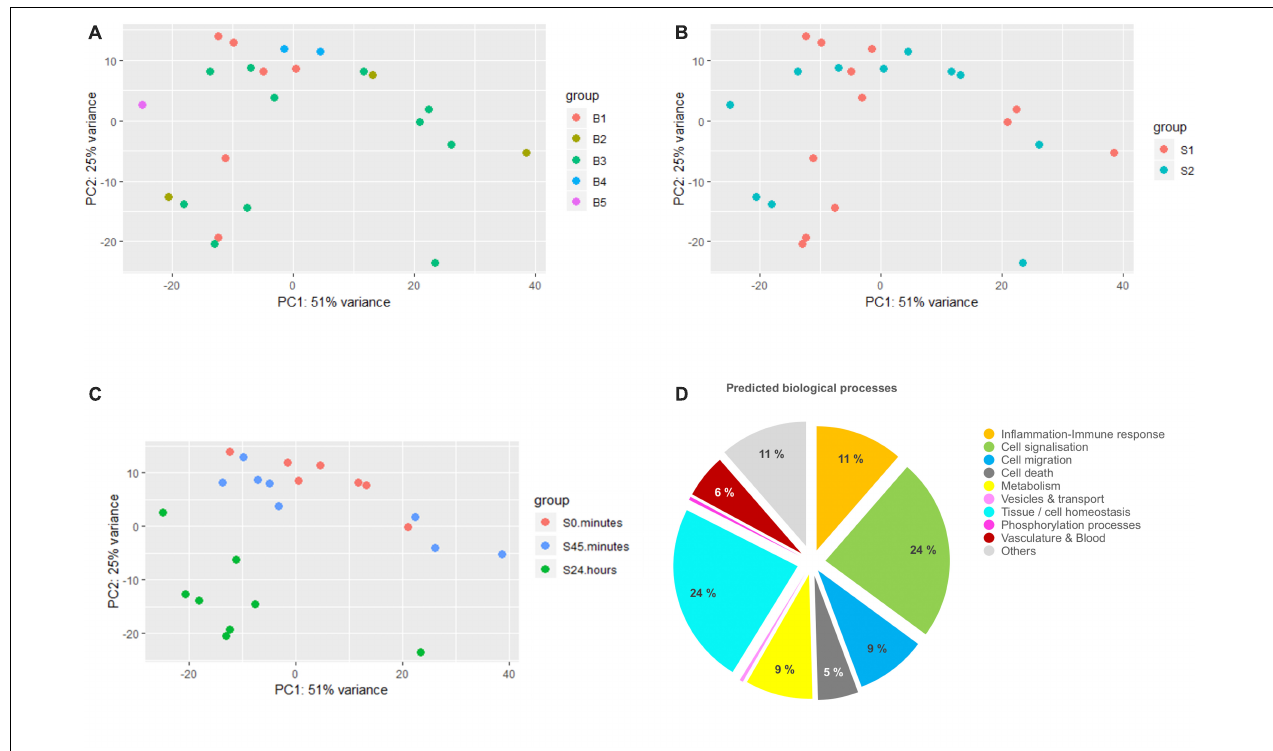
FIGURE 1 | Differential analysis and gene ontology analysis. (A–C) represent principal component analysis (PCA) plots of the data clustered by surgeon (S1 and S2), batch (B1–B5), and time (0 min, 45 min, and 24 h), respectively. Batch corresponds to the different pools of library construction during sequencing. (D) Pie chart showing the major biological processes expressed as the percentage of GO terms detected in the gene ontology analysis of the differentially expressed transcripts